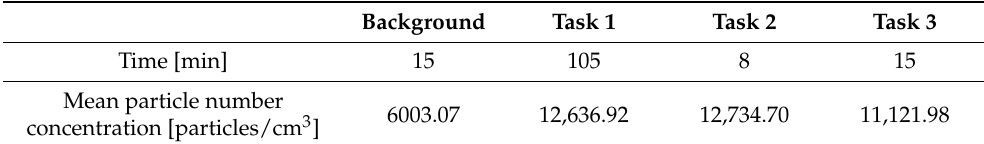
Table 3. Results provided by the CPC.